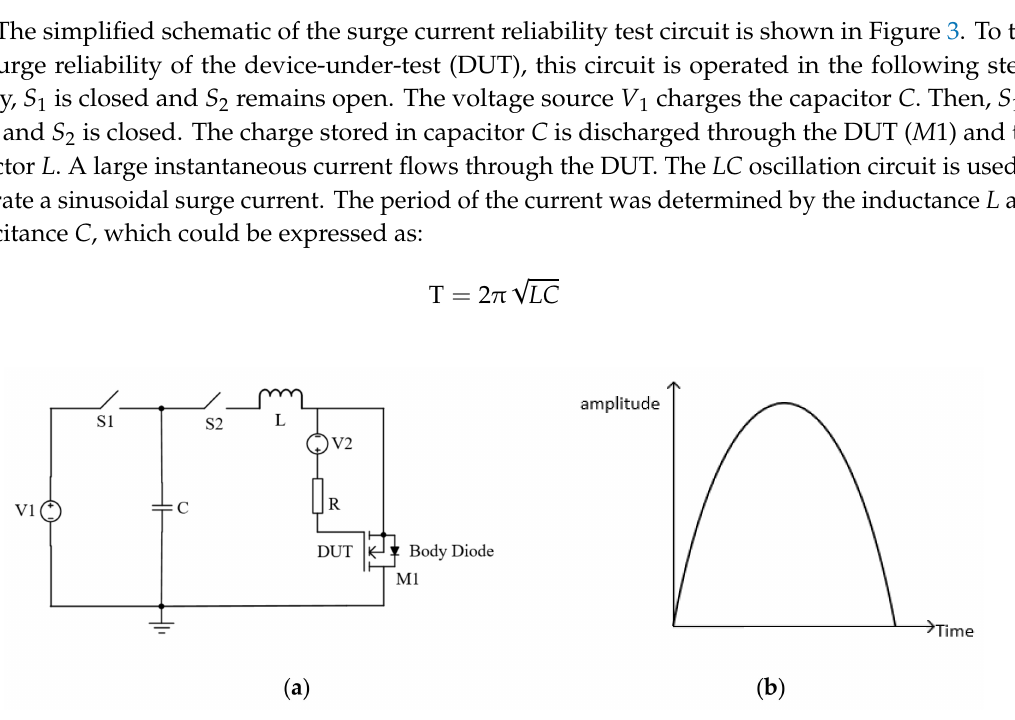
Figure 3. ( a ) Simplified schematic of the surge current test circuit, ( b ) the waveform of the surge current.